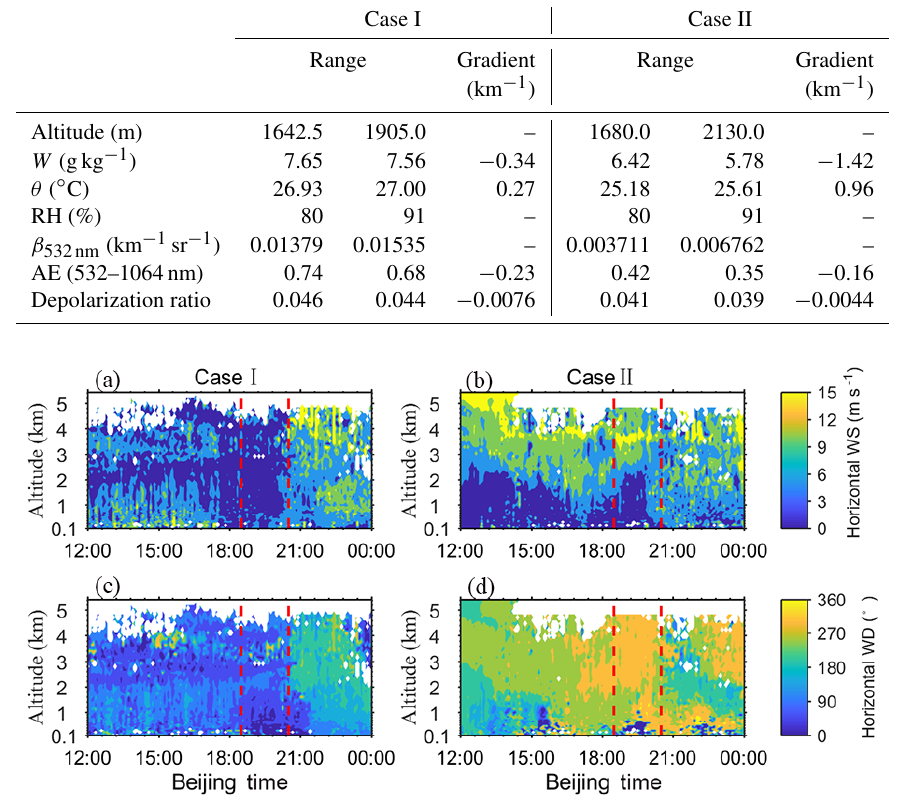
Figure 4. Time series of Doppler-lidar-retrieved (a, b) horizontal wind speed and (c, d) horizontal wind direction on 21 May 2016 (Case I, left-hand panels) and 23 May 2016 (Case II, right-hand panels). Red dashed lines outline the time range 18:30–20:30CST. The analyzed layers are 1642.5–1905.0m for Case I and 1680.0–2130.0m for Case II.